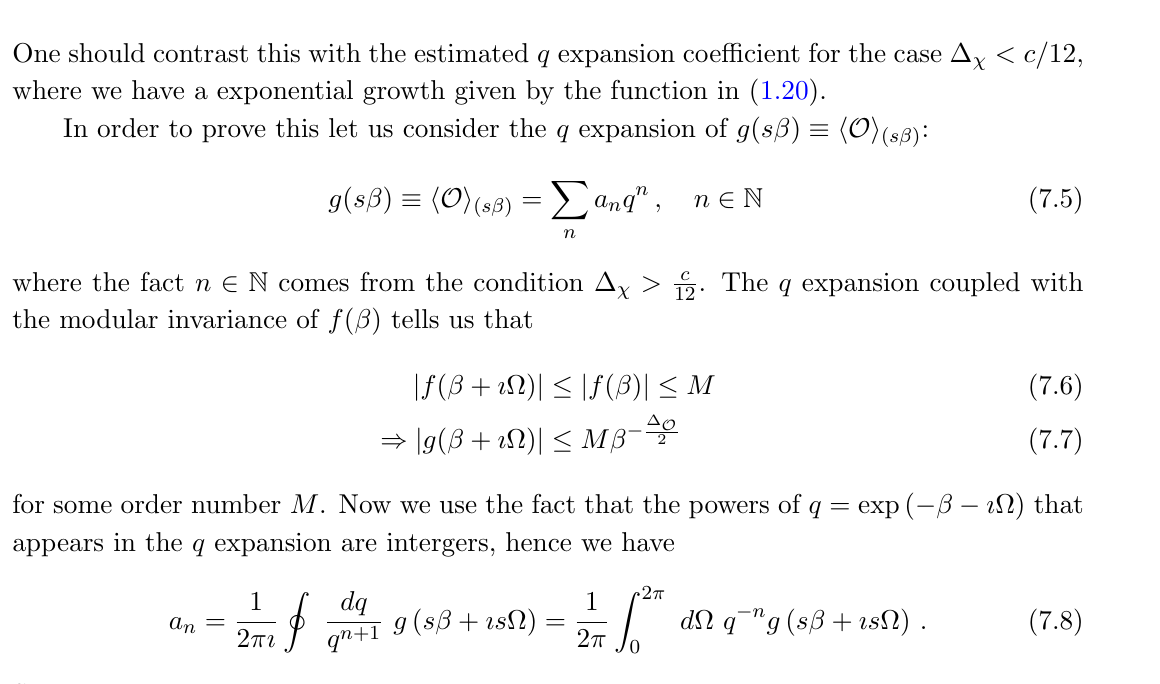
Figure 5 . The q expansion coe(cid:14)cient as a function of (cid:1) is bounded by (cid:1) (cid:1) O = 2 , the black lines are (cid:6) (cid:1) (cid:1) O = 2